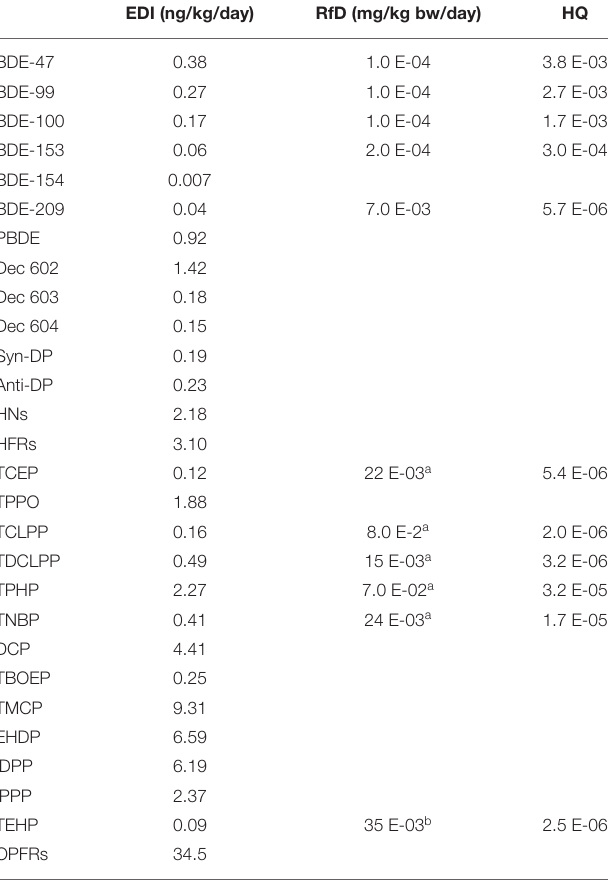
TABLE 3 | Calculated of estimated daily intakes (EDI) and hazard quotient (HQ) by consumption of eel ( Anguilla Anguilla ) from Bizerte Lagoon. EDI